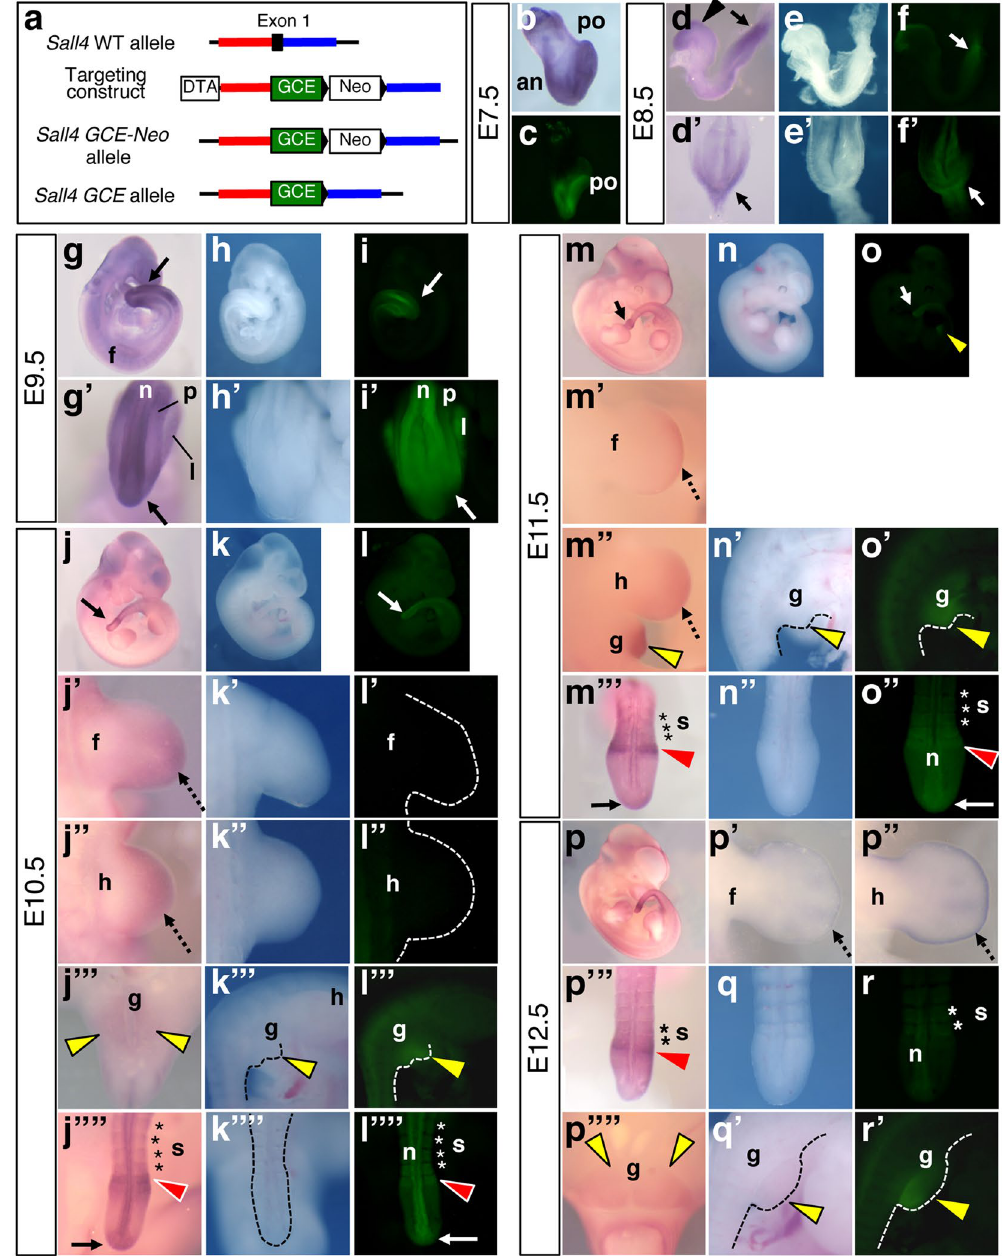
Figure 1. The GFP signals of Sall4 GCE embryos were detectable in cells/tissues with high levels of Sall4 mRNA expression. ( a ) Schematic of targeting strategy to knock-in the GCE cassette into the exon 1 of the Sall4 gene. ( b , d ,d’, g ,g’, j –j””, m –m’”, p –p””) Sall4 mRNA expression pattern of indicated stages by whole mount in situ hybridization. Bright field images ( e ,e’, h ,h’, k –k””, n –n”, q ,q’) and the GPF images ( f ,f’, i ,i’, l –l””, o –o”, r ,r’) of Sall4 GCE embryos at indicated stages. At E8.5 ( d –f’) and E9.5 ( g –i’), arrowheads and arrows point to the head and the posterior tip of the body. Panels in b,c,d,e,f,g,h and i show lateral views of the whole embryo. Panels in d’,e’,f’,g’,h’ and i’ show dorsal views of the posterior part of the body. At E10.5–E12.5, dashed black arrows point to the signal at the distal part of the limb buds in dorsal views with the anterior to the top (j’,j”,m’,m”,p’,p”). Arrows point to the posterior tip of the tail ( j ,j””, l ,l””, m ,m”’, o ,o”). Red arrowheads point to the anterior presomitic mesoderm in dorsal views (j””,l””,m’”,o”,p’”). Yellow arrowheads point to the external genital primordium (j’”,k’”,l’”,m”,n’, o ,o’,p ””,q’,r’). The genital primordia are shown in the ventral views (j’”,p””) or lateral views (k’”,l’”,m”,n’,o’,q’,r’). Asterisks in j””,l””,m’”,o”,p’” and r indicate signals in the somites. Abbreviations. an: anterior, f: forelimb bud, g: external genital primordium, h: hindlimb bud, l: lateral plate mesoderm, n: neural tube, p: paraxial mesoderm, po: posterior, s: